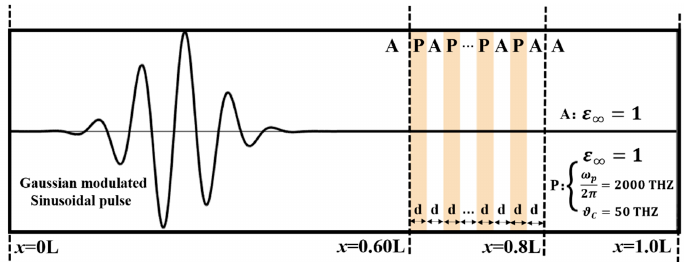
Figure 8. Schematic computational domain and incident Gaussian-modulated sinusoidal pulse through 1D plasma PhCs. The simulation results for the thin, middle, and thick layer thicknesses are presented in Figures 9–11, respectively. Figure 9a shows that, at time t = 0 fs, the initial Gaussian- modulated sinusoidal pulse at a frequency of 4000 THz is in the air zone. At time t = 15 fs, Figure 9b shows that when the EM waves propagate through the two plasma layers on the left side, only a very small part of the incoming EM waves is reflected back to the air